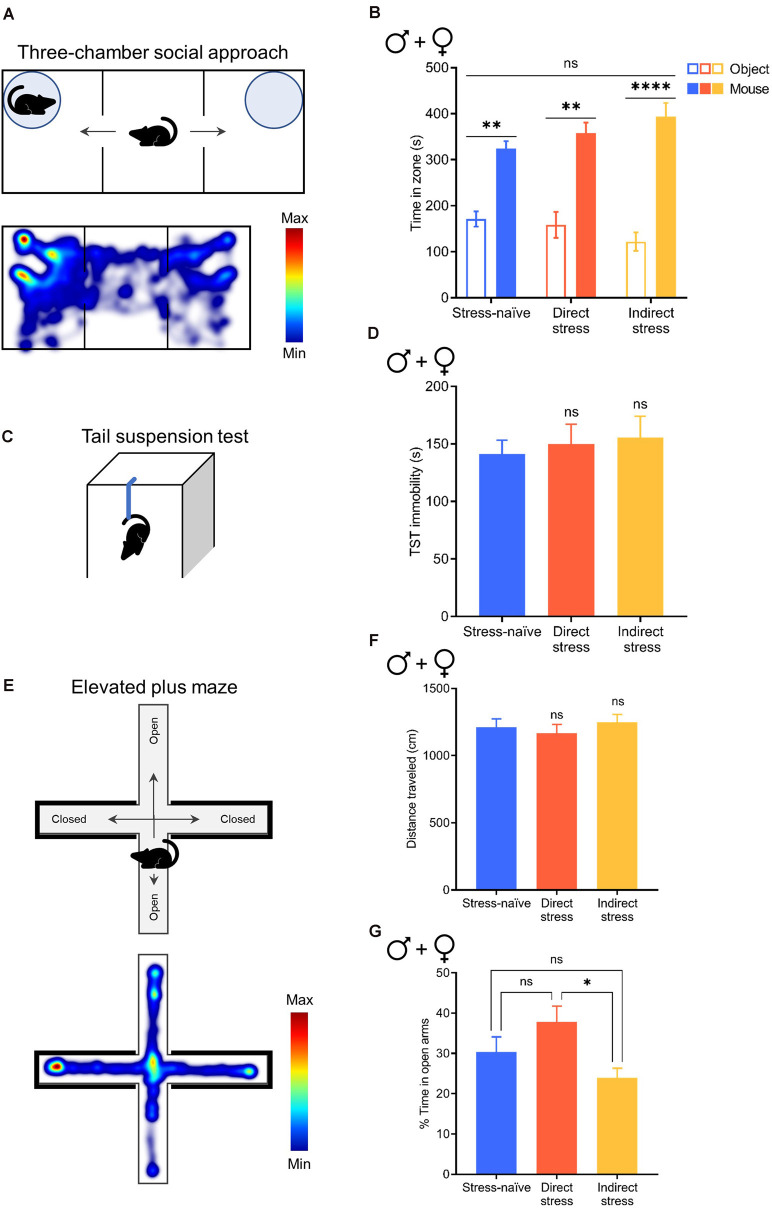
Direct and indirect stress do not affect social interaction, depression-like behavior, or anxiety-like behavior 1week after stress exposure. (A) Cartoon depicting the three-chamber social approach assay (top) and a representative heatmap of activity during this test (bottom). (B) Time spent in the novel object and novel mouse zones in the three-chamber social approach assay in stress-naïve (n = 8), directly stressed (n = 6), and indirectly stressed (n = 7) males and females. (C) Cartoon depicting the tail suspension test (TST). (D) Time spent immobile for the 6-min duration the TST in stress-naïve (n = 10), directly stressed (n = 11), and indirectly stressed (n = 10) males and females. (E) Cartoon depicting the elevated plus maze (EPM, top) and a representative heatmap of activity in the EPM (bottom). (F) Distance traveled in the EPM in stress-naïve (n = 32), directly stressed (n = 25), and indirectly stressed (n = 29) males and females. (G) Percent of total time spent exploring the open arms of the EPM in stress-naïve (n = 32), directly stressed (n = 25), and indirectly stressed (n = 29) males and females. Error bars, SEM. ns: P > 0.05, *P < 0.05, **P < 0.01, ****P < 0.0001.